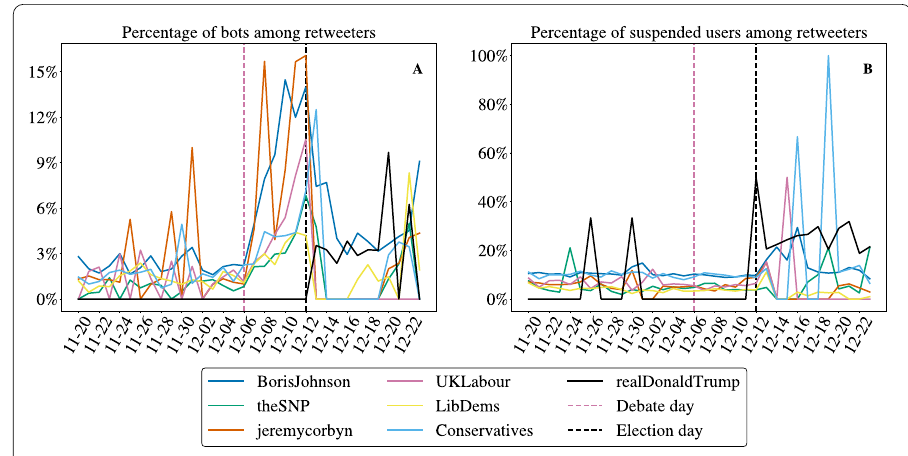
Figure 13 Percentage of bots ( A ) and suspended users ( B ) among retweeters for some main verified accounts. The percentages of suspended accounts increase after the election day, while in the case of